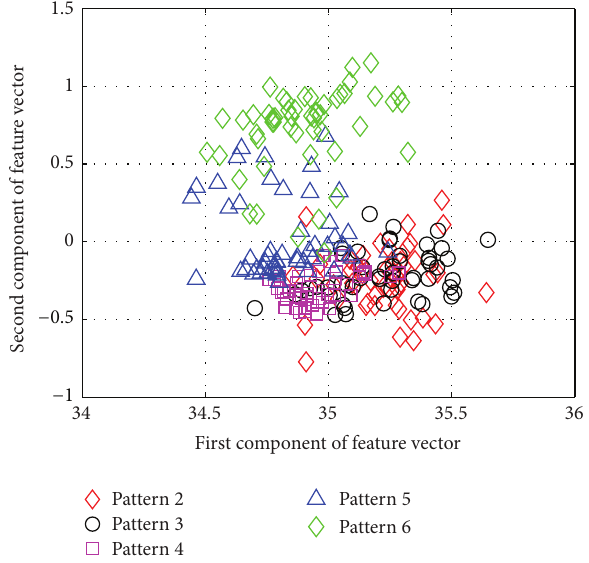
Figure 14: The DFT feature vectors of data patterns in first scenario from sensor node 232.